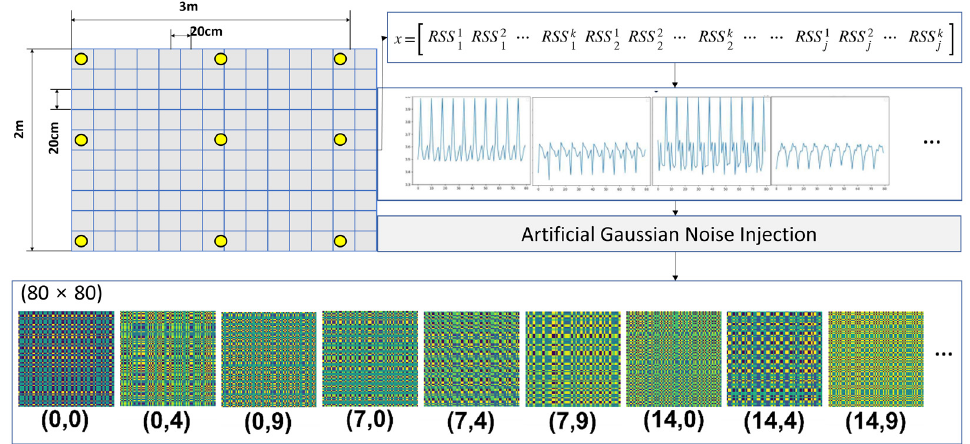
Figure 9. Examples of generated MTF images from the measured RSSIs from our testbed.